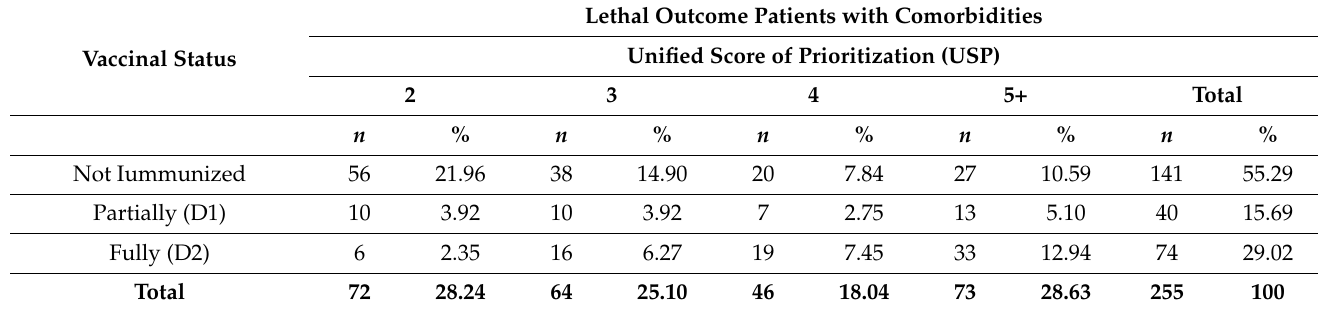
Table 4. Lethal outcome patients with comorbidities admitted between June and August 2021 and grouped according to their vaccinal status and the Unified Score for Prioritization